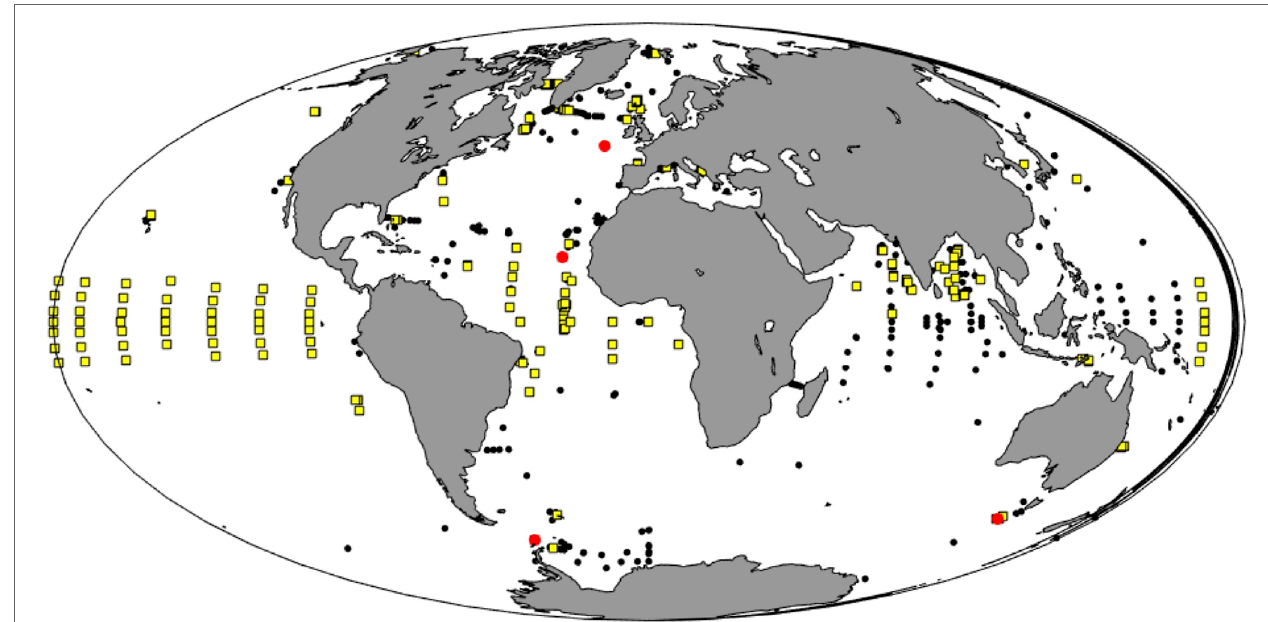
FIGURE 1 | Global map of OceanSITES sites (black dots) as registered in the OCG metadatabase OceanOPS ( www.ocean-ops.org ). Sites that are registered with the variable “Plankton” (red circles) and sites that have acoustic Doppler current profiler installations (yellow squares) are GEOMAR Helmholtz Centre for Ocean Research Kiel, Kiel,